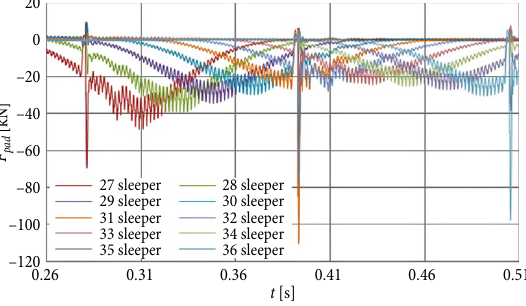
Fig. 11. Forces operating on sleepers from the rail (through the pad)